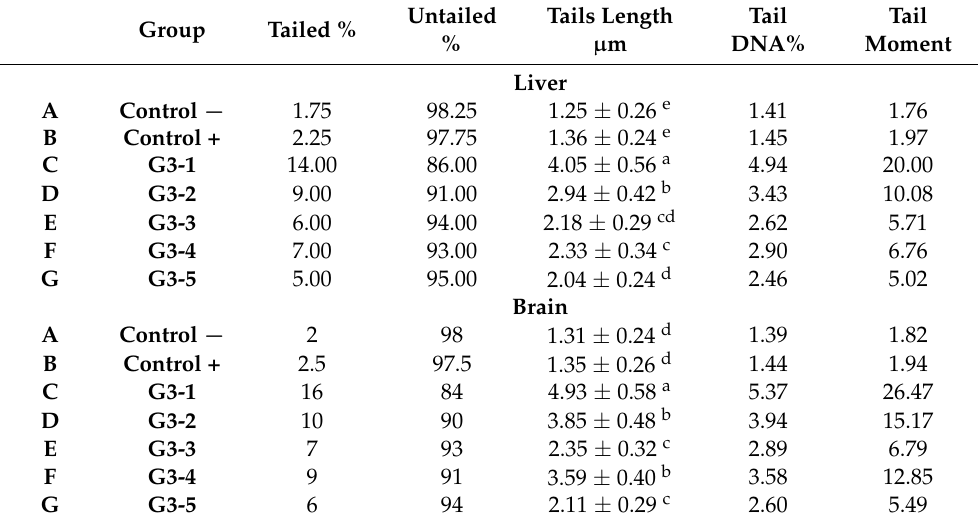
Table 10. Comet assay parameters obtained by the image analysis in rat livers and brains for all of the groups. Group Tailed %